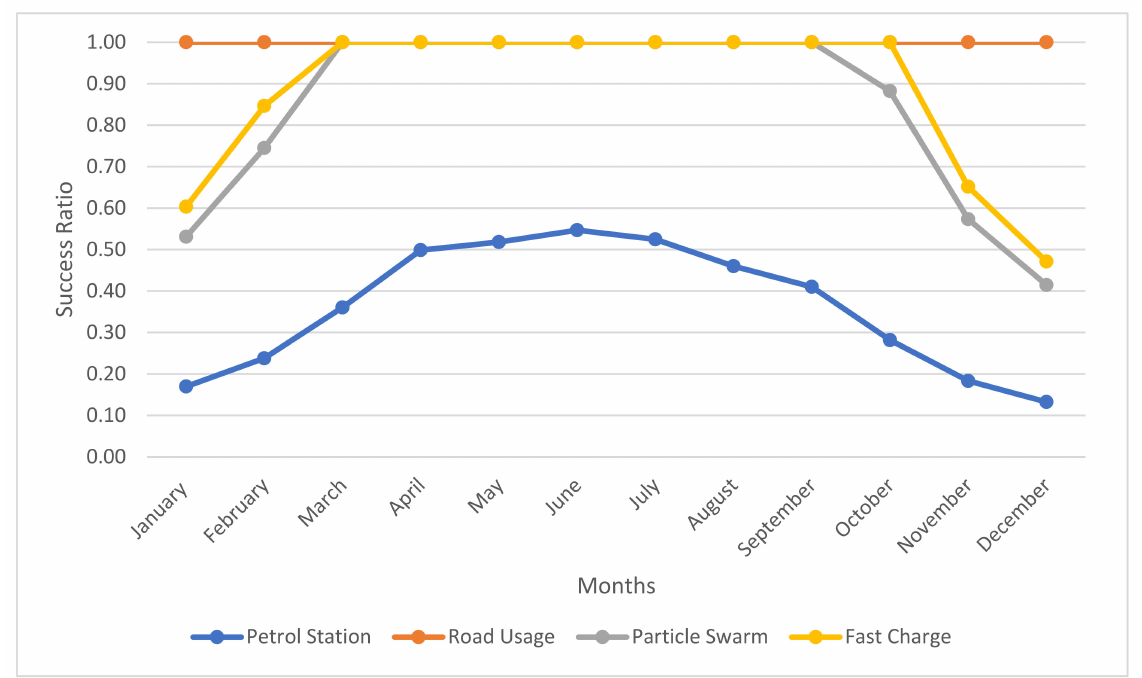
Figure 5. The monthly success ratios for the non-grid-connected system of each charging profile over a